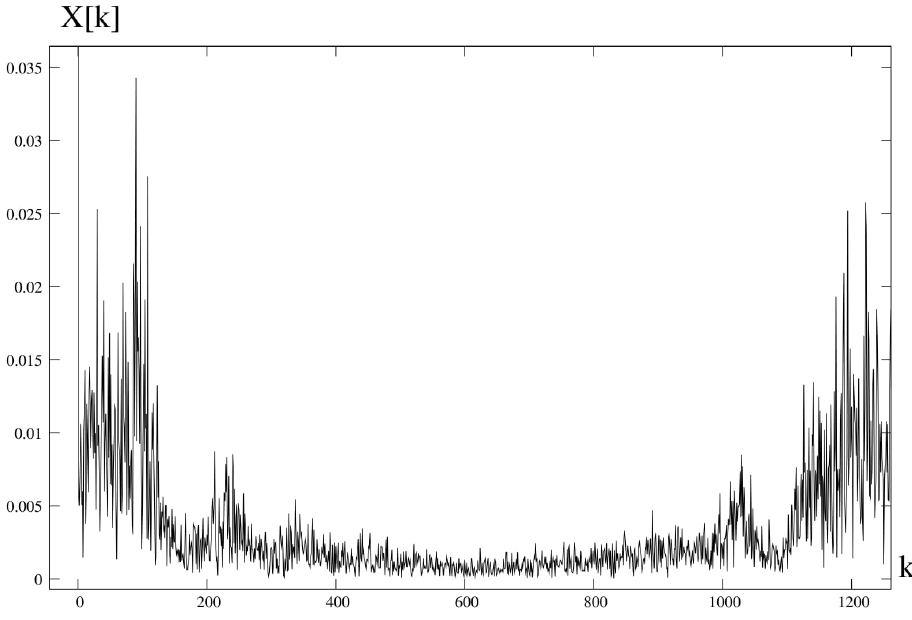
Figure 4. Harmonics of the amplitude spectrum for Da = 0.13 and τ r =